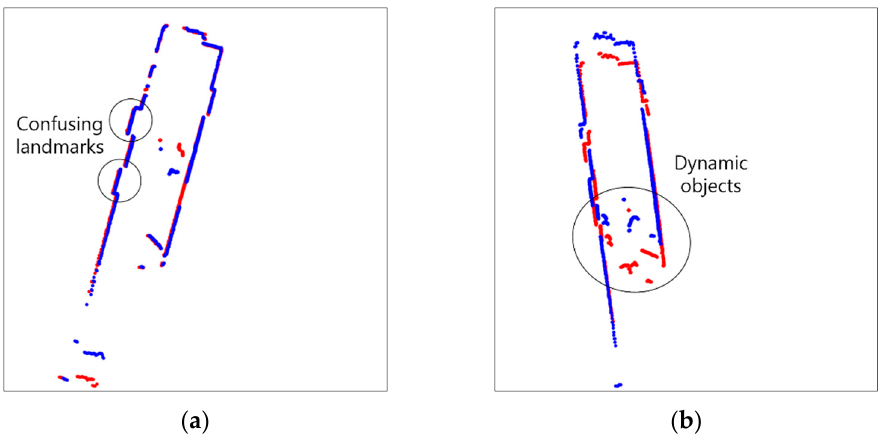
Figure 14. Scan matching images in environment 2 (Red: Previous scan, blue: current scan). ( a ) Normal matching images; ( b ) faulty matching images.